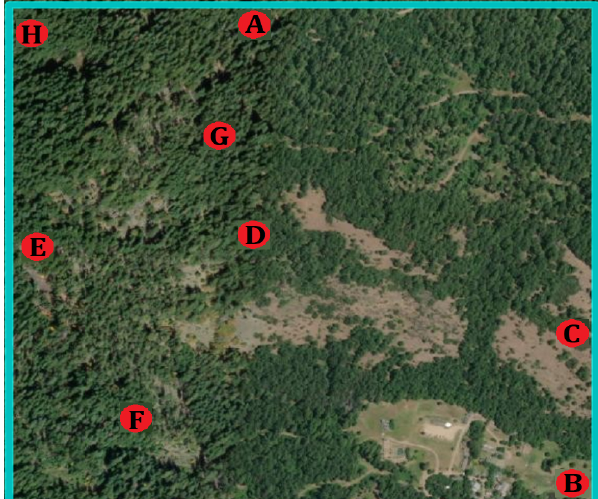
Figure 5. 2D satellite imagery of the area under study with 4 UGV paths defined by their starting and ending positions as letters (pairs of two letters). Table 1. Comparison against energy-cost minimization of